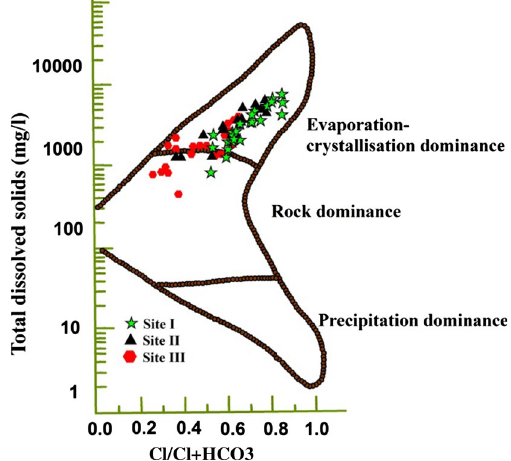
Fig. 8 Gibbs variation diagram (TDS vs. [Cl/(Cl + HCO